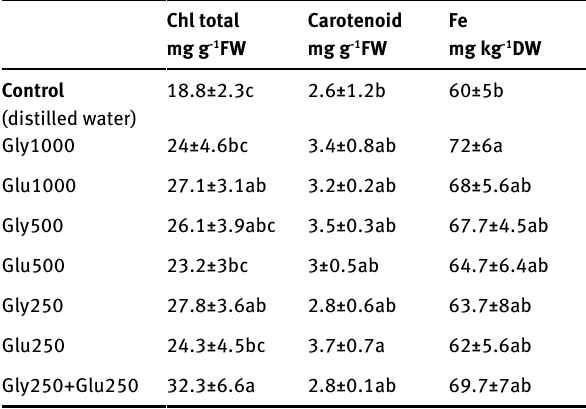
Gly and Glu represent glycine and glutamine amino acids, respectively.